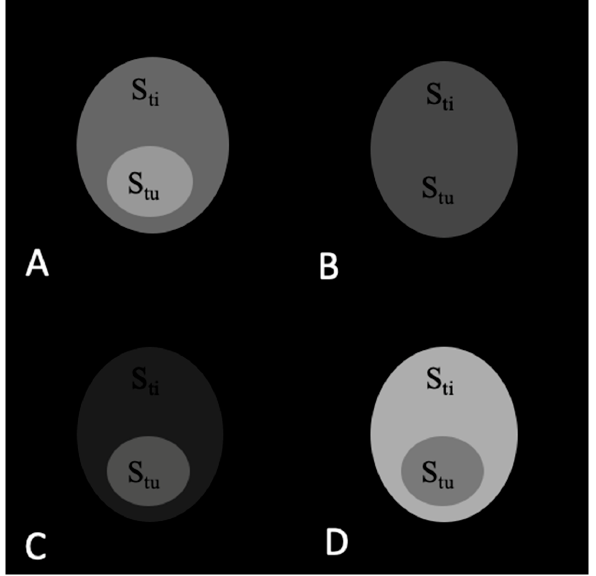
Figure 4. MR images of the tumor phantom model after injection of the T 1 contrast agent. ( A ) T 1 w. ( B ) T 2 w. ( C ) Subtracted T 1 w − T 2 w. ( D ) Added T 1 w + T 2 w. The highest TC value is 2.67 in image ( C ).